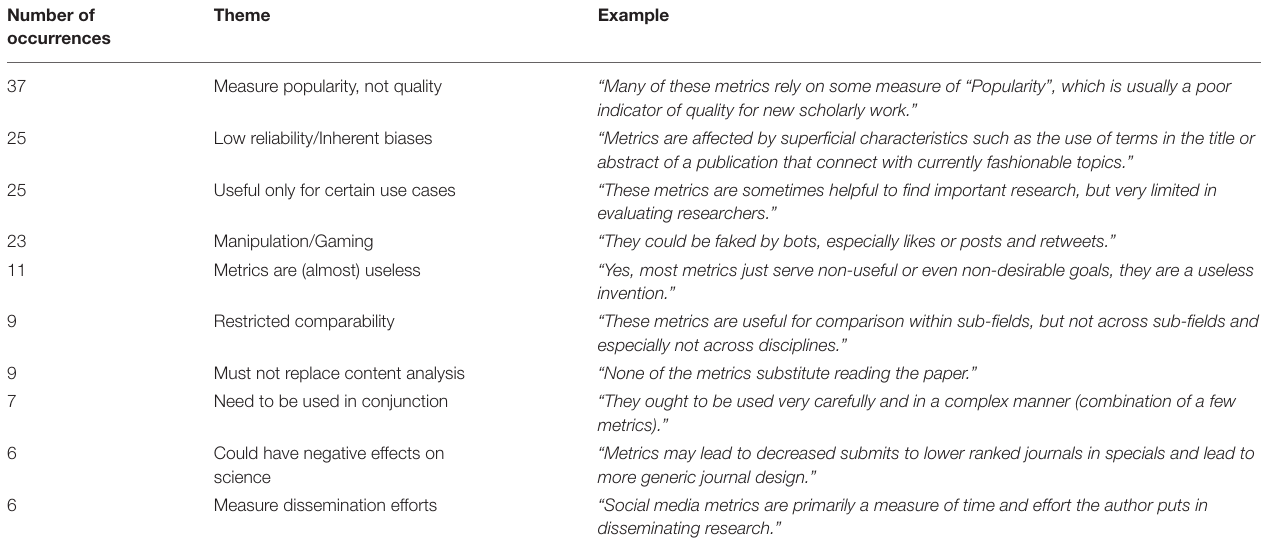
TABLE 3 | Survey responses—concerns regarding the usage of impact metrics. Number of